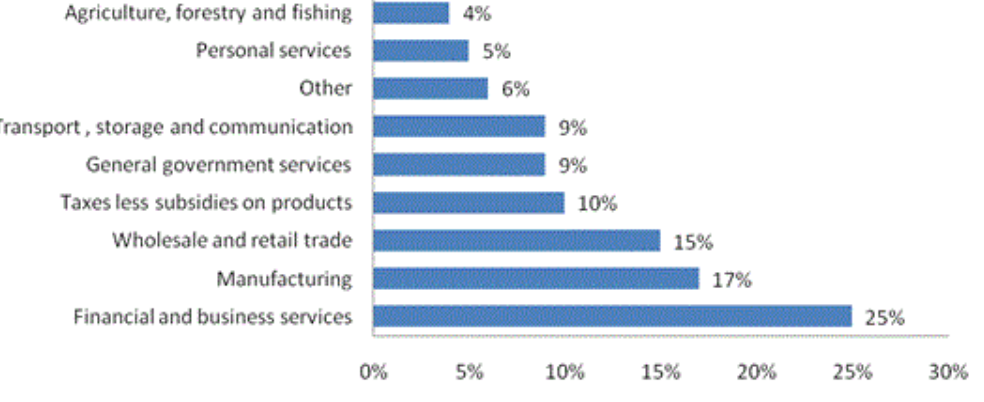
Figure 3: Percentage contribution per industry to Western Cape GDP (Source: Adapted from Statistics South Africa, 2006:71) Table 4: Contribution of the Western Cape districts to the South African GDP and Western Cape GDP Share of South Share of Western Cape Region African GDP Western Cape (%) GDPR (%) Cape Town 11.2% 76.6% Cape Winelands 1.5% 10.5% Eden 0.9% 6.1% West Coast 0.6% 4.0% Overberg 0.3% 2.4% Central Karoo 0.1% 0.5% Total 14.6%